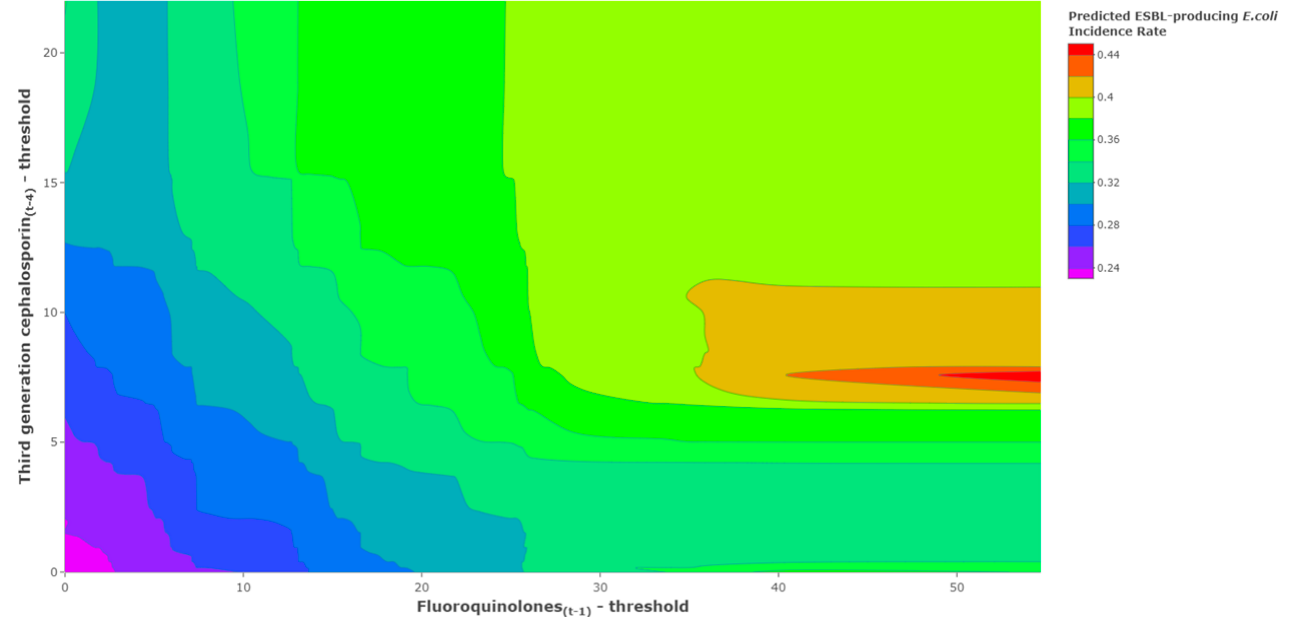
Figure 2. Illustrations of associations between antibiotic use above their identified thresholds and predicted ESBL-producing E. coli incidence rates.